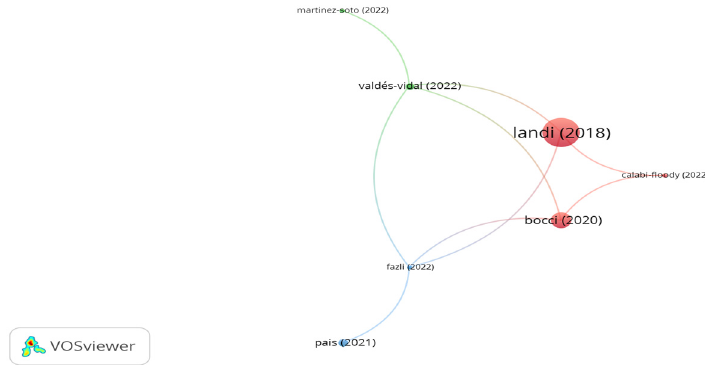
Figure 21. Network visualization of tire textile fibers.